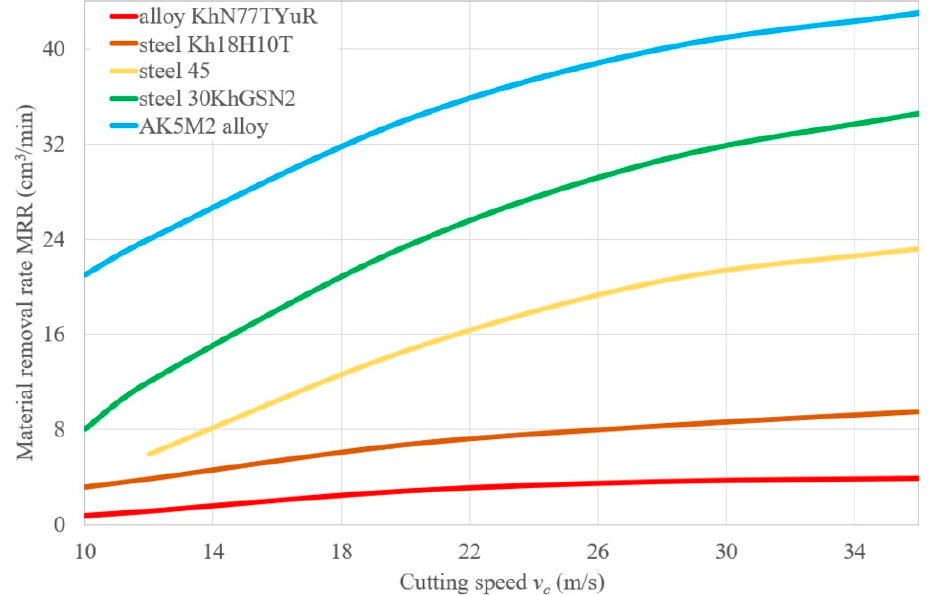
Figure 3. The dependences of the material removed rate (MRR) on the cutting speed of belt grinding of various materials: alloy KhN77TYuR; steel Kh18H10T; steel 45; 4—steel 30KhGSN2; 5—AK5M2 alloy: workpiece speed v w = 0.058 m/s; vertical oscillation frequency w os = 200 mm − 1 ; the value of the vertical oscillation Aos = 3 mm; grit = F60. Table 4. Output parameters of belt grinding of various materials obtained at various cutting speeds ( v c ). Material